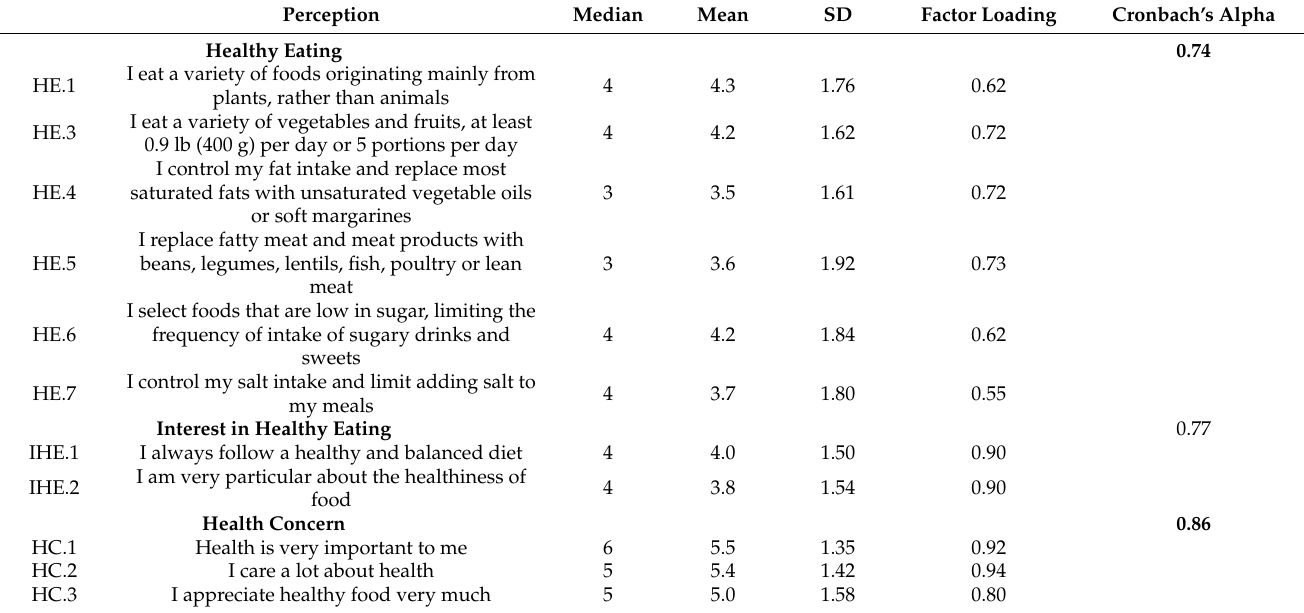
Table A2. Factor analysis results of healthy eating, interest in healthy eating, and health concern (N = 499). Perception Median Mean SD Factor